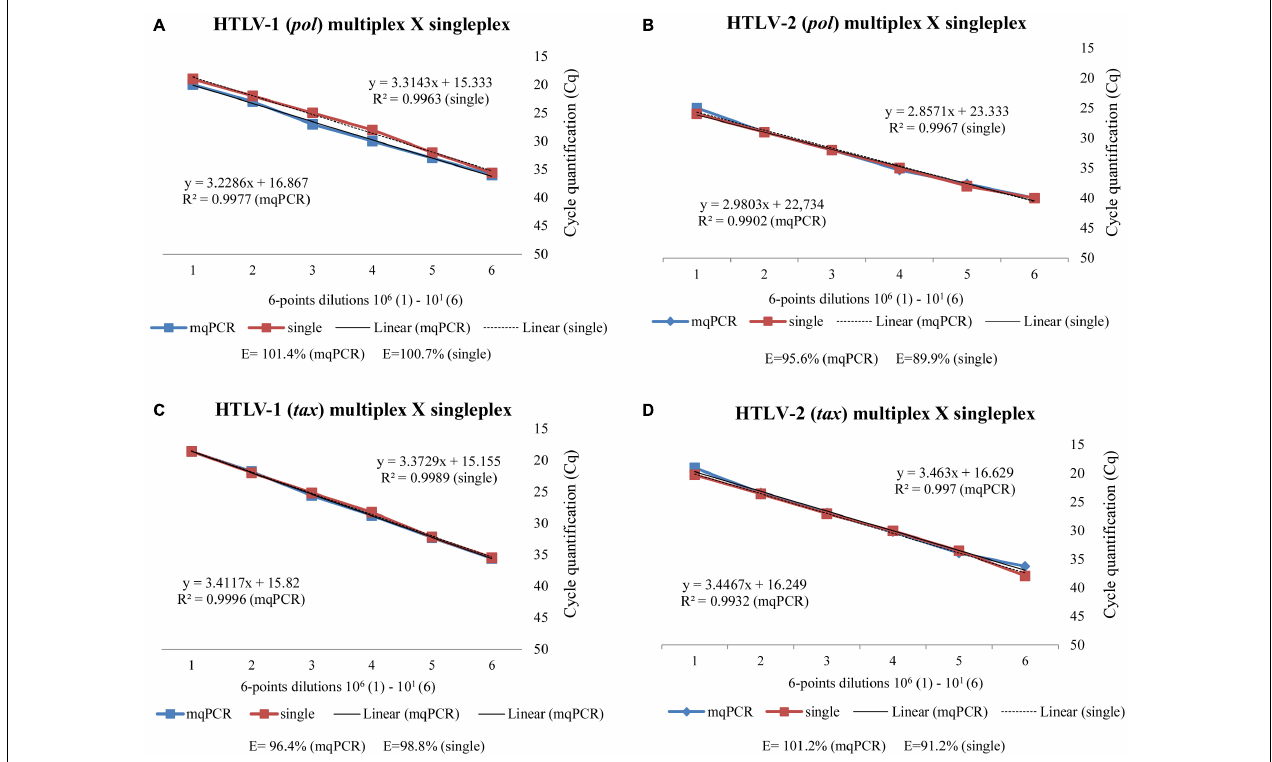
FIGURE 1 | Comparative efficiency of the singleplex and multiplex qPCR_HTLV in detecting HTLV-1/-2 pol (A,B) and tax (C,D) target genes using serial plasmid dilutions and linear regression analyses, conducted in ROCHE platform.